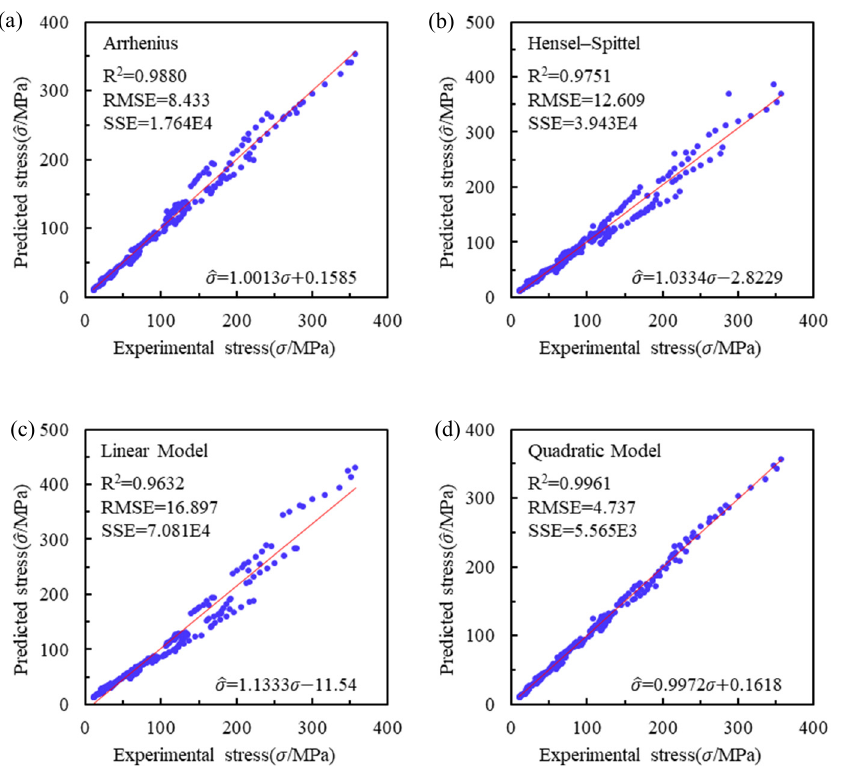
Figure 10. Predictability of flow stress by ( a ) Arrhenius model; ( b ) HS model; ( c ) linear Model; ( d ) quadratic model.